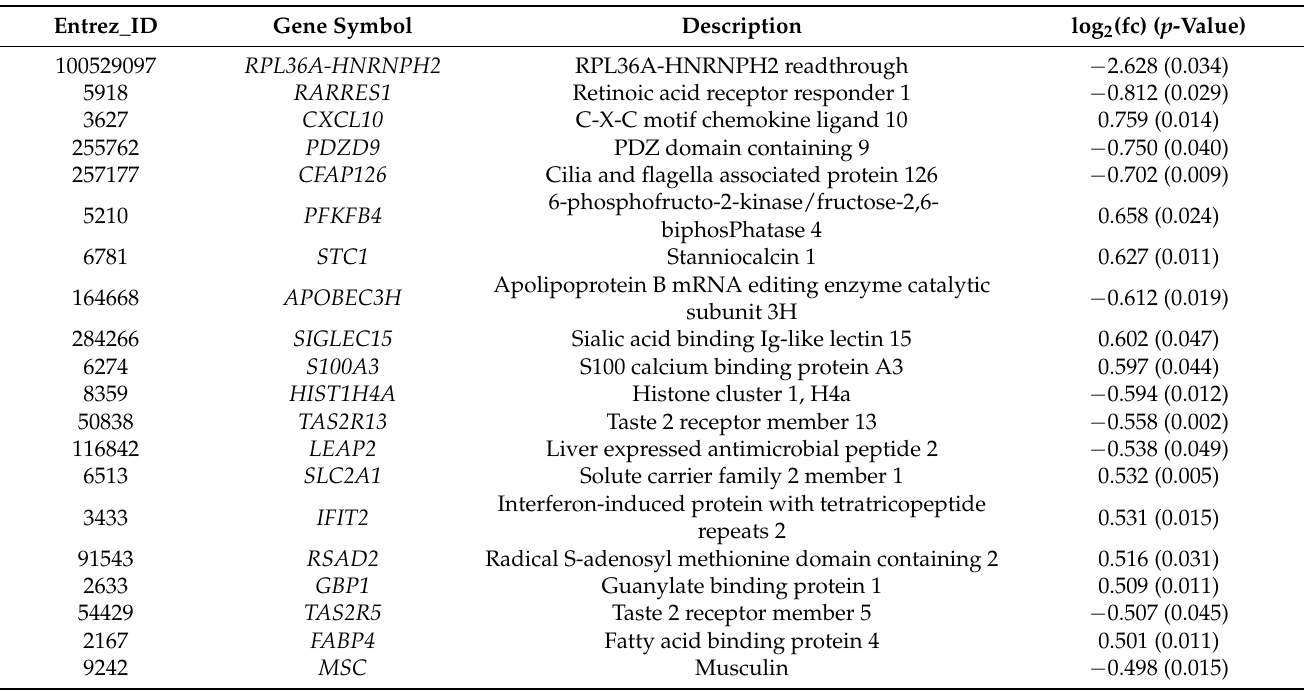
Table 1. List of 20 genes showing the most significantly modulated expression following low-dose radiation in